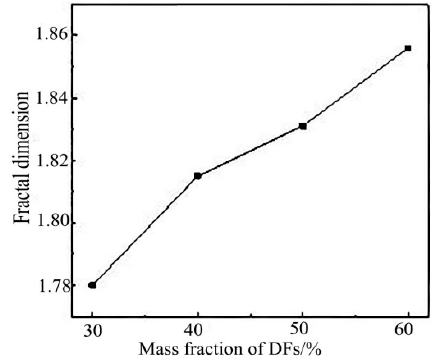
Figure 12. Relationship between fractal dimension and mass fraction of DFs.